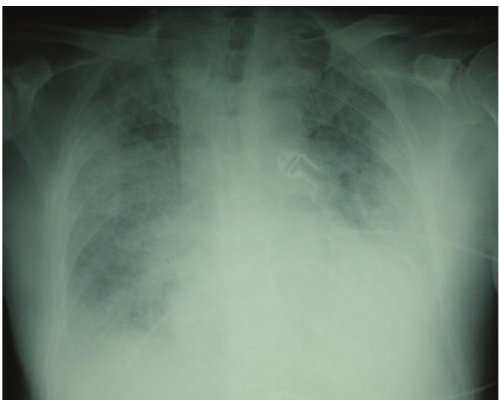
Figure 1: Postero anterior radiograph of the chest obtained on admission.